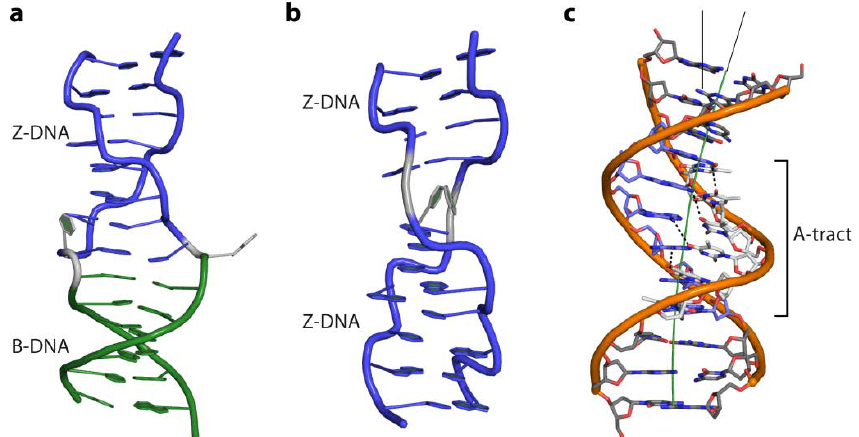
Figure 5. ( a ) Cartoon representation of a BZ-junction (PDB code 2ACJ) and ( b ) a Z-Z junction (PDB code 3IRR); ( c ) Intrinsic curvature of an A-tract containing DNA (PDB code 1D98) due to the propeller twist of its base pairs. Non-Watson-Crick H-bonds, between the base steps in the major groove, which rigidify the DNA strand, are shown as dashed